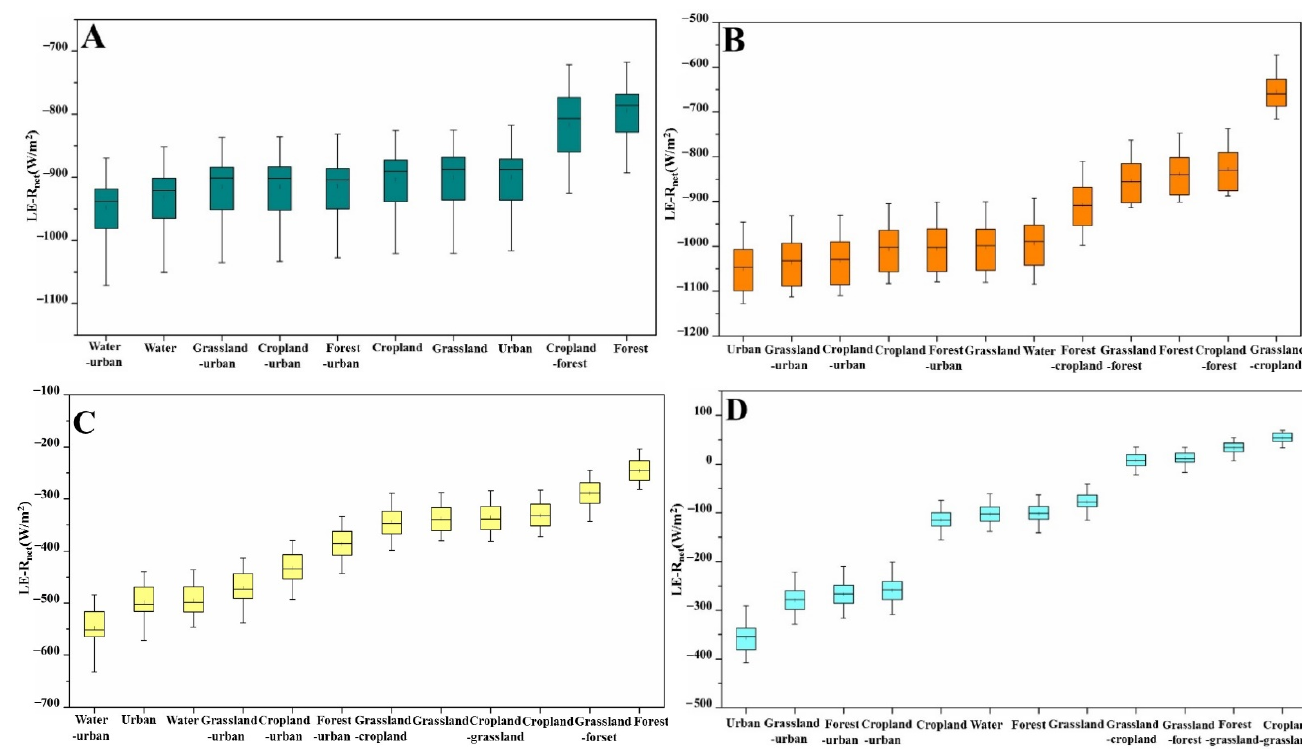
Figure 17. Statistical characteristic values of LE-R net based on different land types from 2000 to 2015 (( A ) Jinan City, ( B ) Zhengzhou City, ( C ) Lanzhou City, ( D ) Xining City).